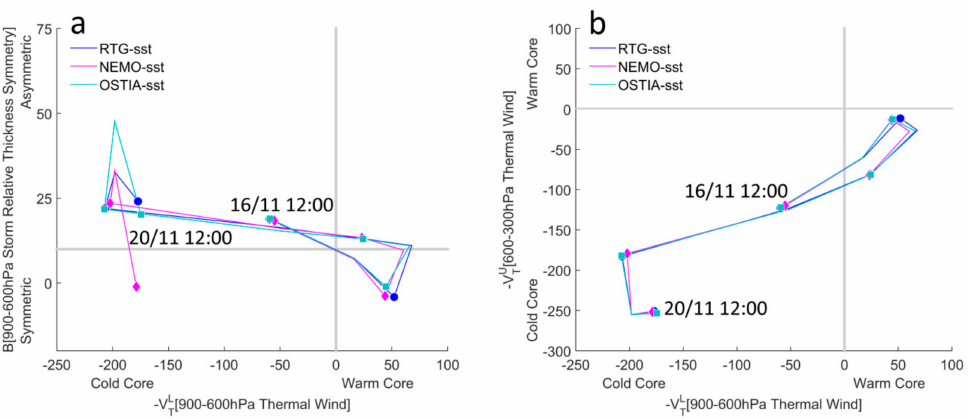
Figure 10. Phase space diagrams of ( a ) − V L vs. − V U (600–300 hPa) evolution from RTG-sst, NEMO-sst, and OSTIA-sst simulations during cyclone T Numa. Markers are shown every 12:00